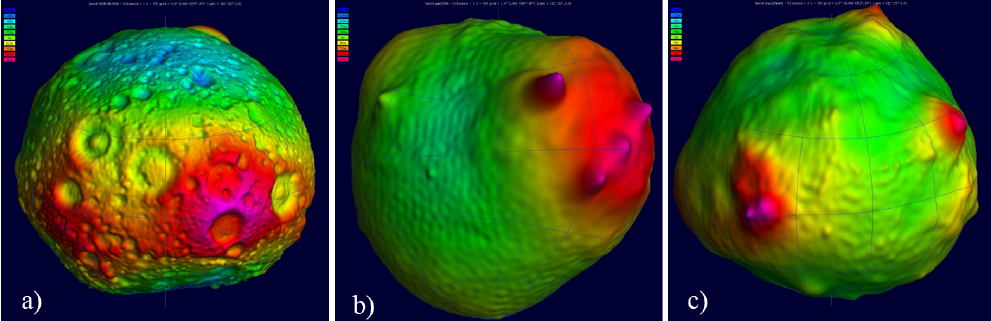
Figure A4. Visualization of other celestial bodies. Panels show geoid undulations of (a) Moon, (b) Mars, and (c)